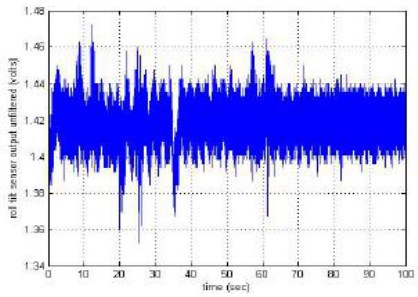
Figure 6 Unfiltered sensor output for roll angle